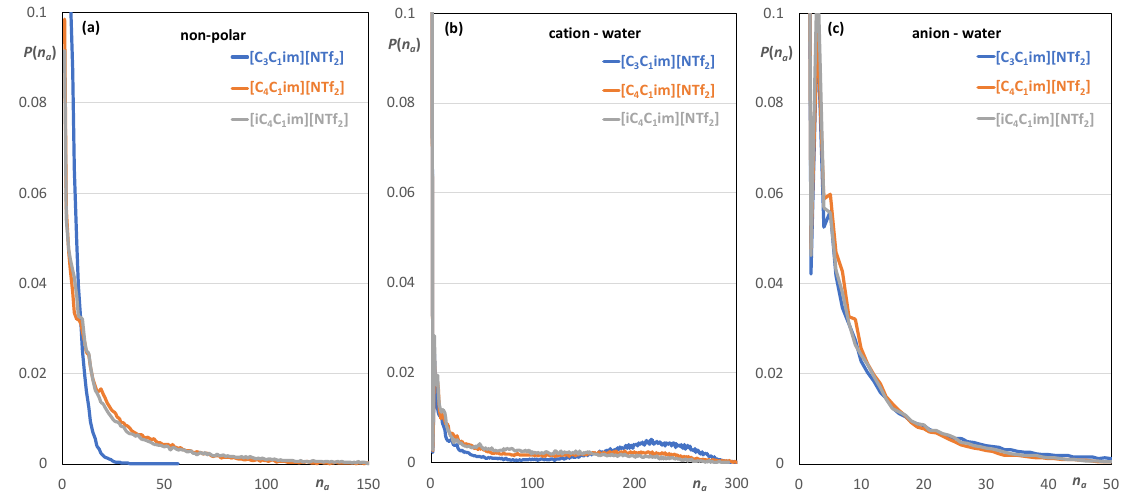
Figure 4. Discrete probability distribution of aggregates in aqueous mixtures X IL = 0.70 (wt IL = 98%) of [C 3 C 1 im][NTf 2 ], [C 4 C 1 im][NTf 2 ], and [iC 4 C 1 im][NTf 2 ]: ( a ) tail–tail; ( b ) cation–water and ( c ) anion–water aggregates.